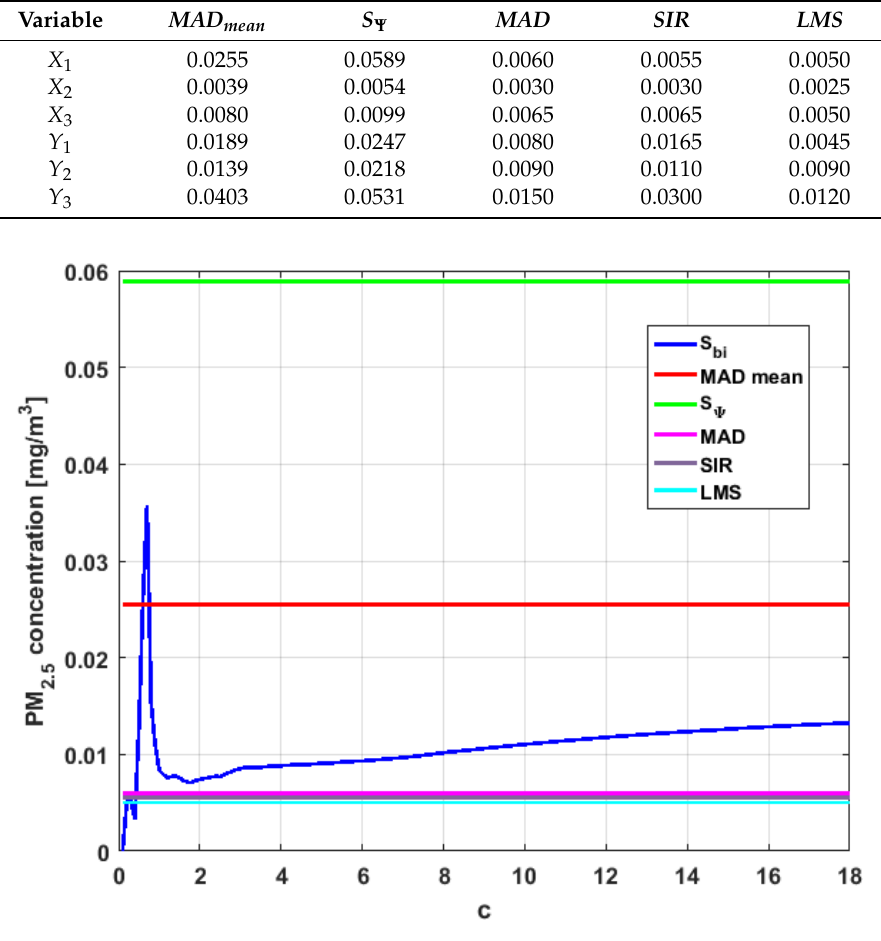
Figure 23. S bi estimates of X 1 Figure 23. 𝑆 𝑏𝑖 estimates of 𝑋 1 .